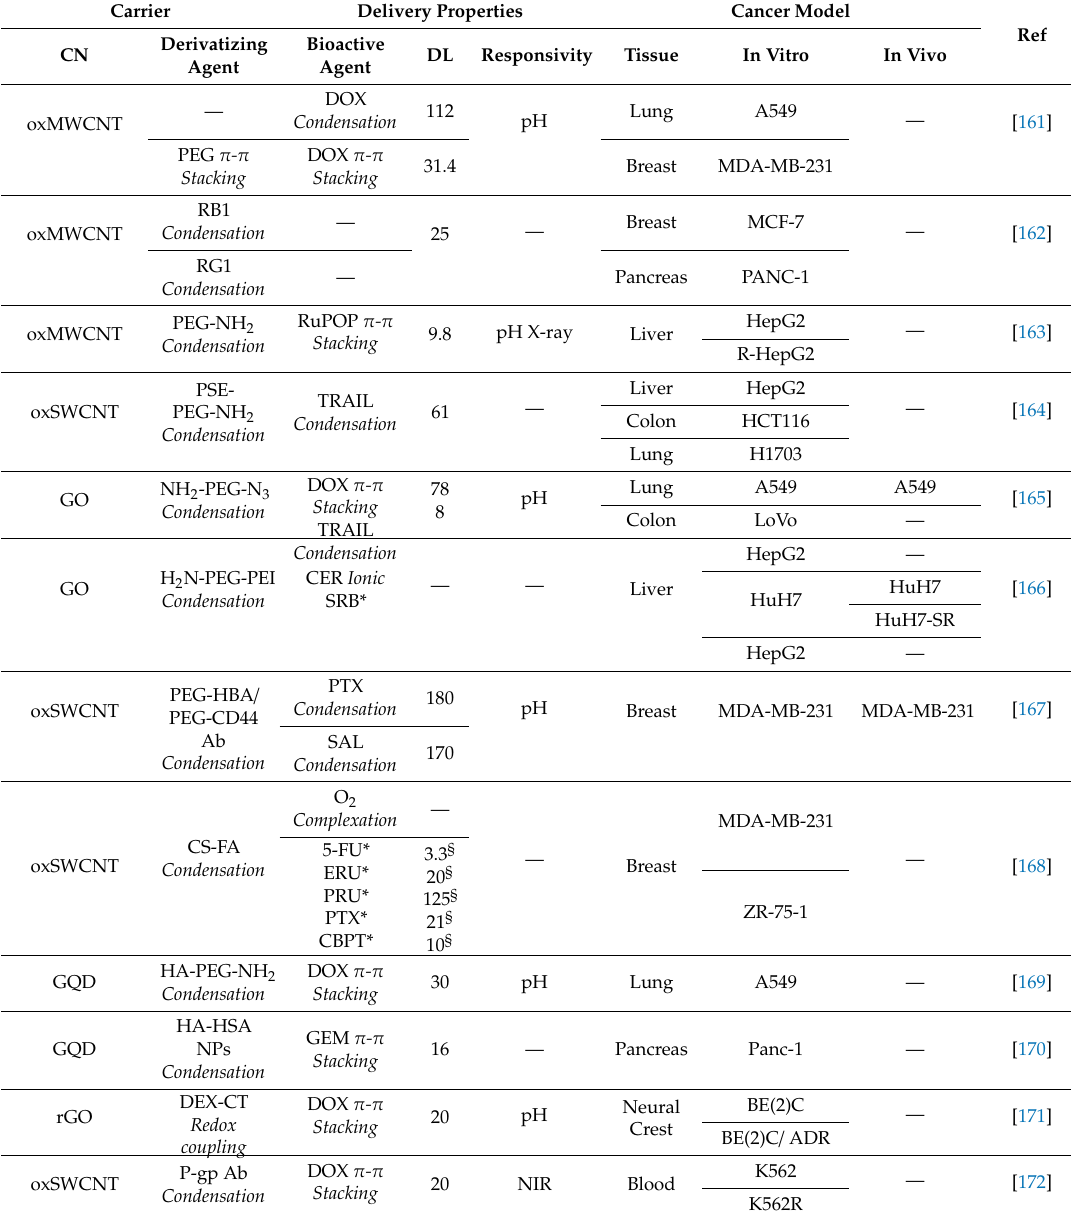
Table 4. MDR reversal by enhanced cellular uptake of covalently functionalized